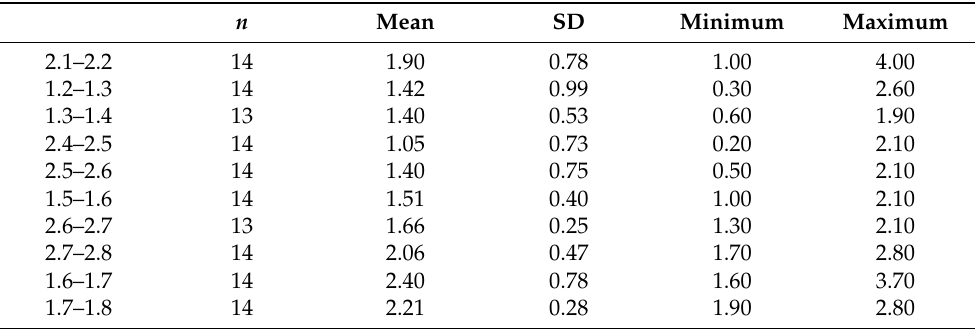
Table 3. Descriptive deviation values at coronal entry-point (mm) of the orthodontic micro-screws placed in the selected tooth positioning.